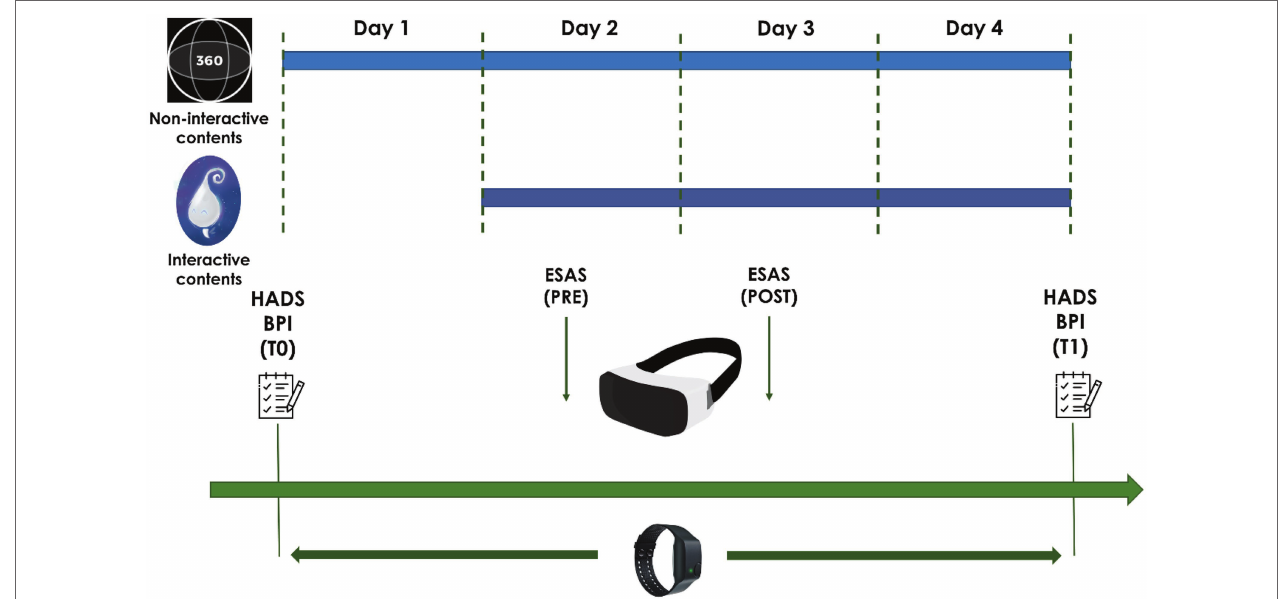
FIGURE 1 | Graphical representation of the VR-based